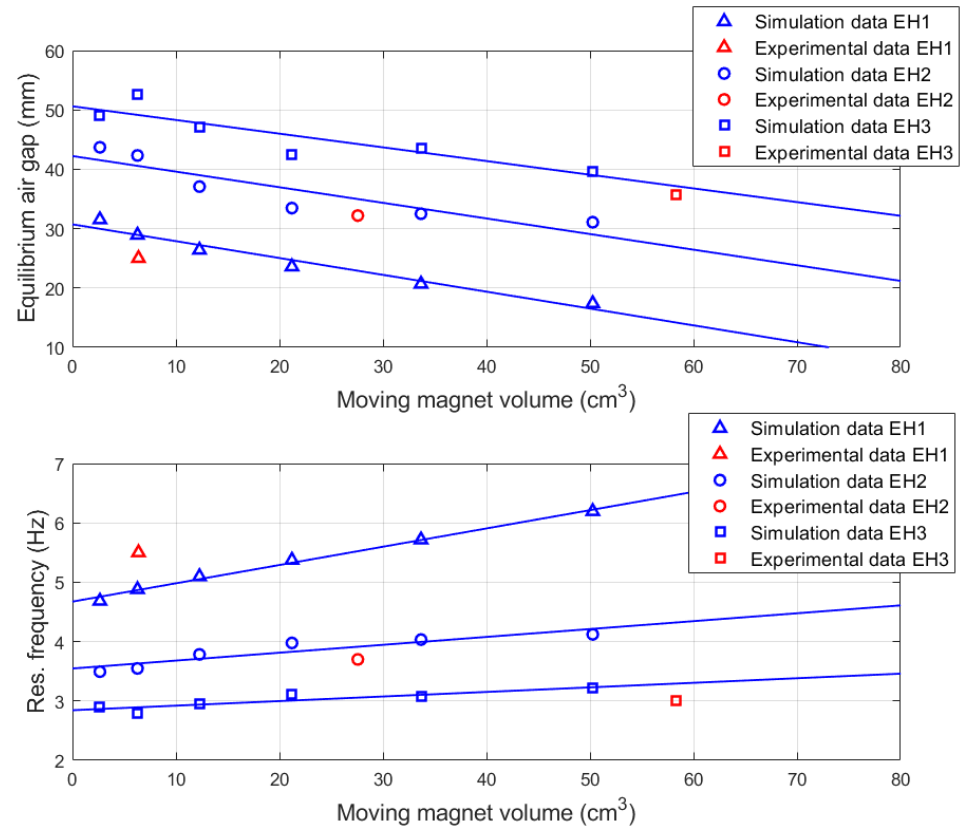
Figure 12. Moving magnet sensitivity